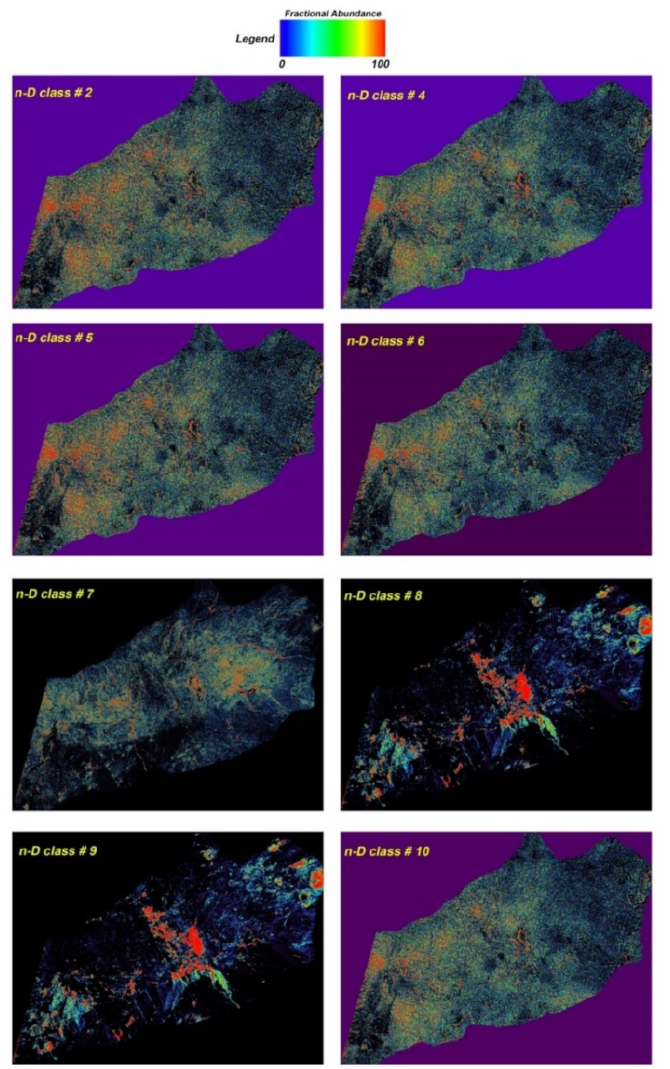
Figure 8. Fraction images of the selected n-D classes derived from MTMF algorithm for the study area. Pseudo-color ramp was applied to greyscale rule images. n-D class #2: hematite; n-D class #4 and n-D class #5: jarosite; n-D class #6: chlorite; n-D class #7: illite; n-D class #8: mixed spectral signatures of illite, muscovite, and montmorillonite; n-D class #9: muscovite/montmorillonite; n-D class #10: mixed spectral signatures of hematite and